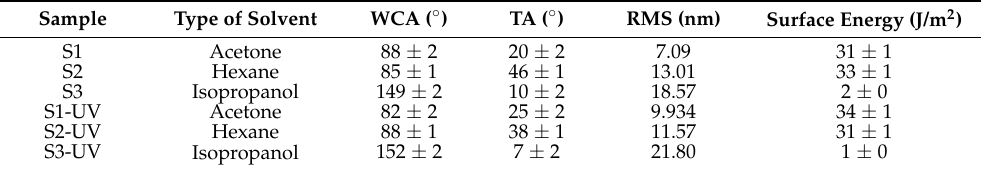
Table 3. Water contact angle, tilting angle, surface energy and the roughness of tiles coated with S1, S2 and S3 that were prepared with different solvents before and after UV